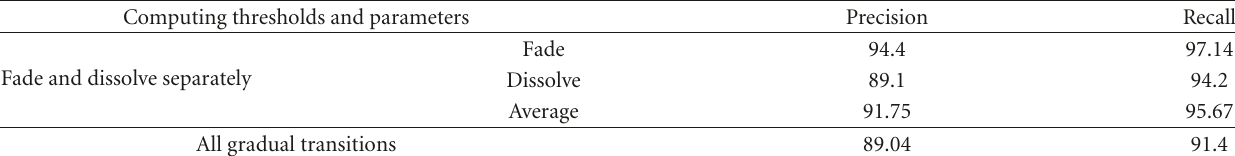
Table 4: The results of the experiments on di ff erent types of gradual transitions. Computing thresholds and